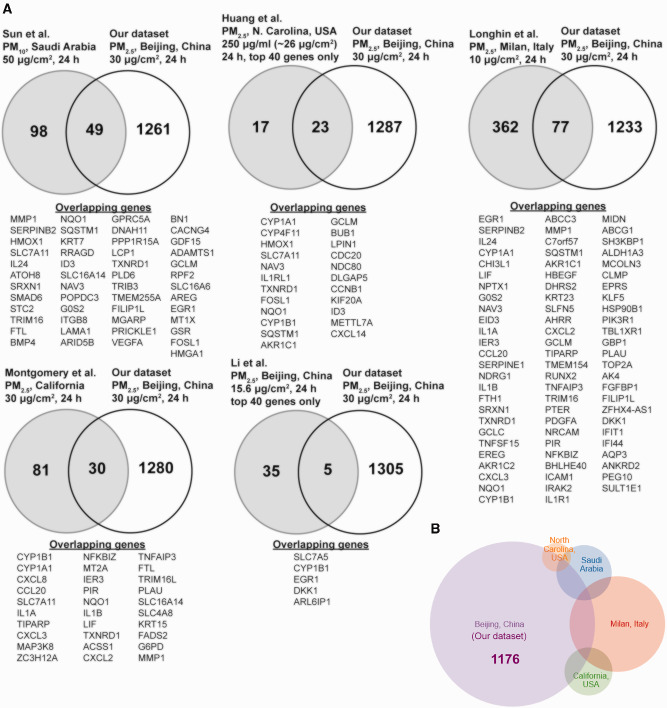
comparison of differentially expressed genes after 24-h treatment with PM2.5 (30 µg/cm2) with genes identified in other published datasets (10–13, 15). (A) The 1310 differentially expressed genes in our dataset were compared to differentially expressed genes found in other published datasets (10–13, 15), with the identity of the overlapping genes listed below. (B) Area-proportional Venn diagram of differentially expressed genes from different datasets with source of PM from different studies indicated.